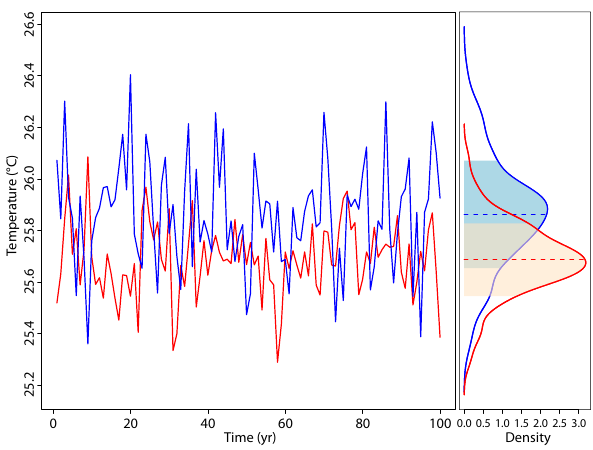
Fig. 6. Comparison of two temperature samples from the deglacia- tion in the Pacific Ocean, offshore Mexico (15 ◦ N, 120 ◦ W). The left panel shows the annual mean temperature evolution over a 100- year sample taken from the reference LGM run (in red) and from the deglaciation (at 12ka BP, in blue). The right panel shows the density function associated to that sample on the same temperature axis. The dashed vertical lines in the right panel show the means of the series, the filled areas are the respective intervals corresponding to the standard deviations of each series ( ± σ ).